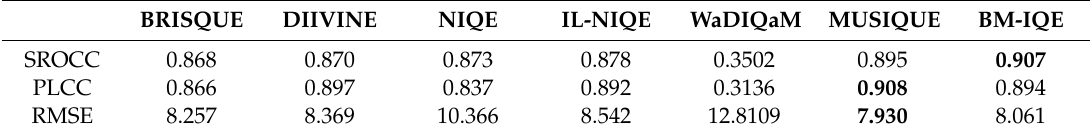
Table 8. Overall performance of NR-IQA algorithms on multiply distorted database.